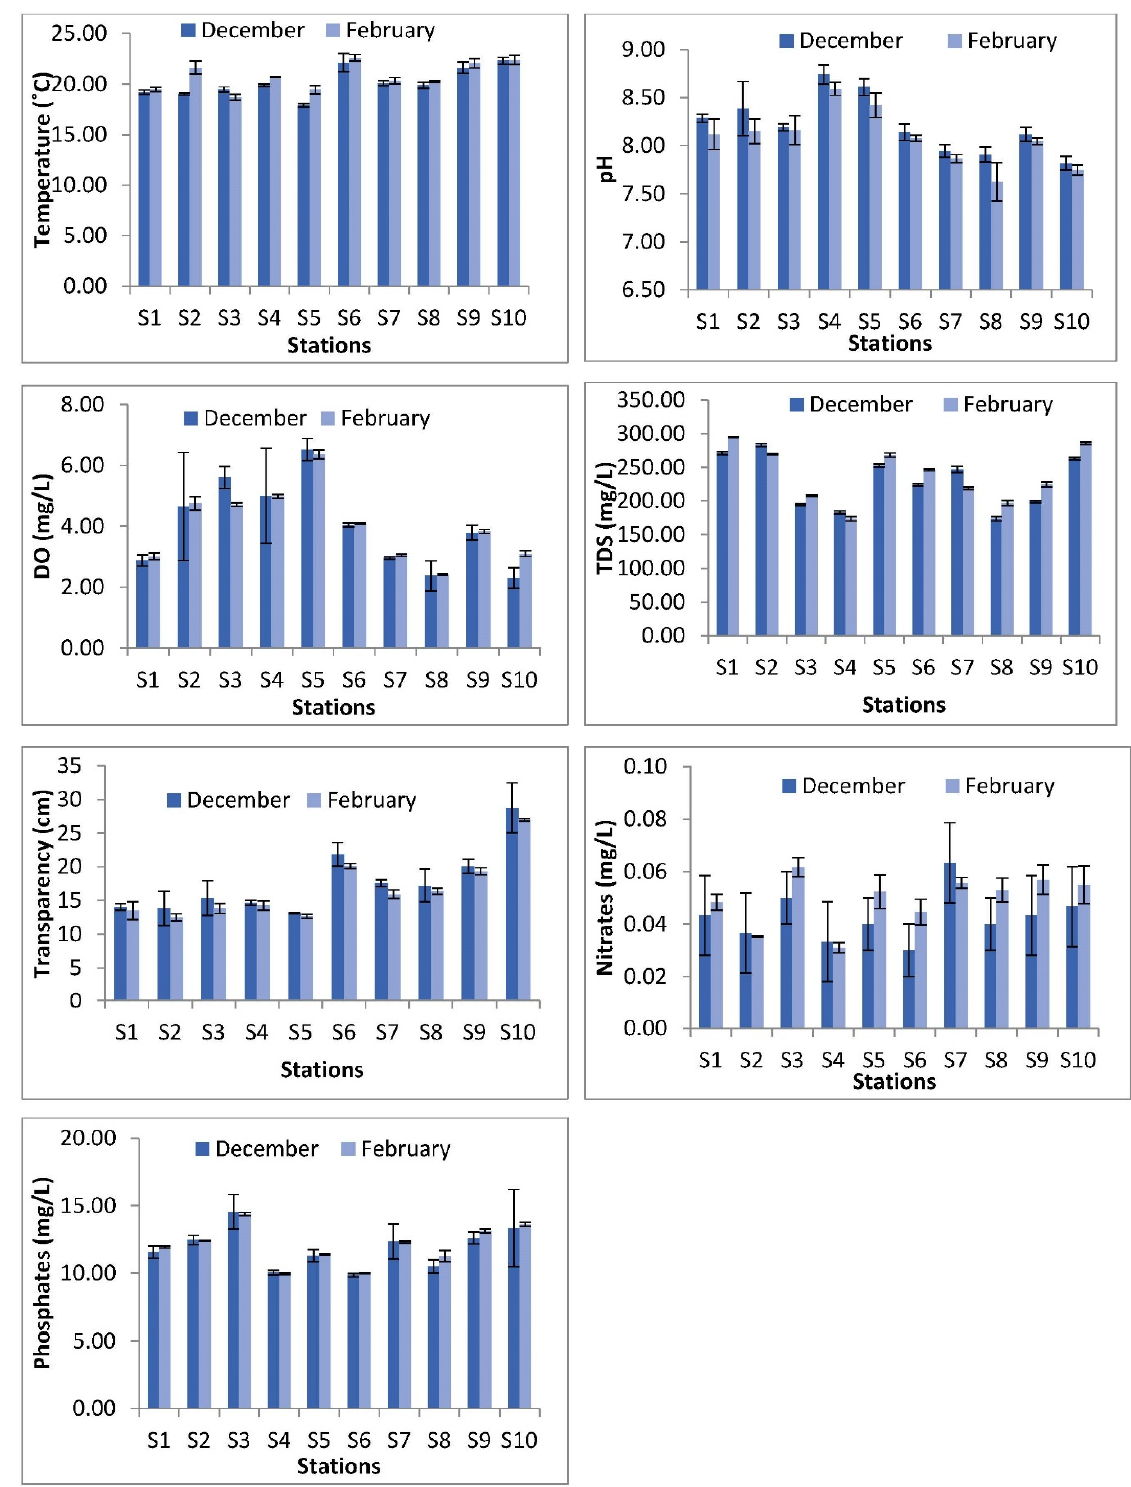
Figure 5. Ecological parameters (mean ± SD) at different stations of the homestead ponds. The pH values ranged from 8.74 ± 0.10 at S4 to 7.82 ± 0.07 at S 10 in December (mean = 8.21 ± 0.09) and from 8.59 ± 0.07 at S4 to 7.62 ± 0.20 at S 8 in February (mean = 8.08 ± 0.10). Highly significant differences in pH of the stations were observed during December ( H = 25.75, p = 0.002) and February ( H = 25.26, p = 0.003). However, no significant differences in pH were found between months ( H = 0.97, p = 0.32).